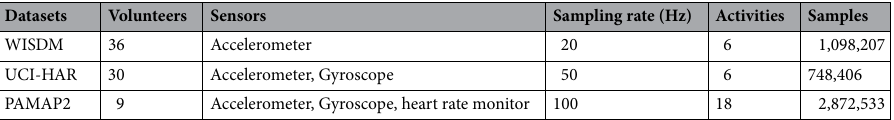
Table 1. Essential information of used datasets.